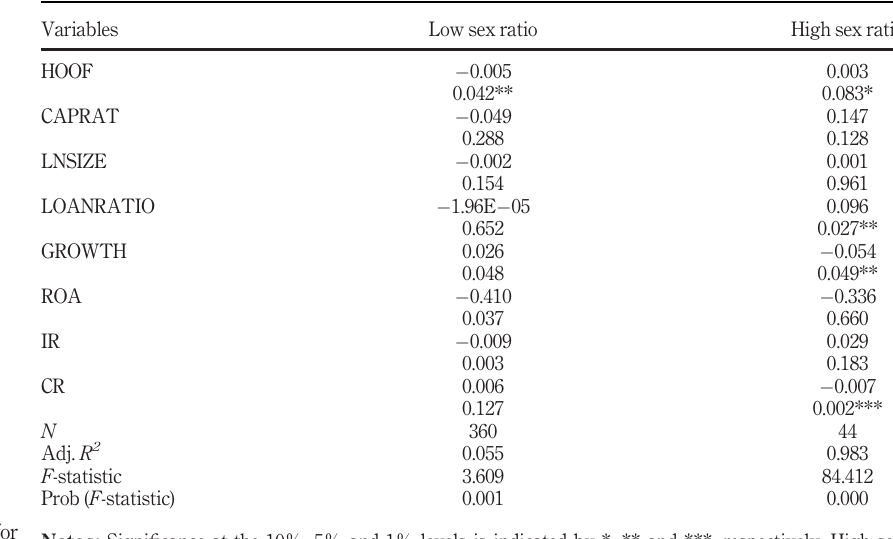
Table 9. Regression result